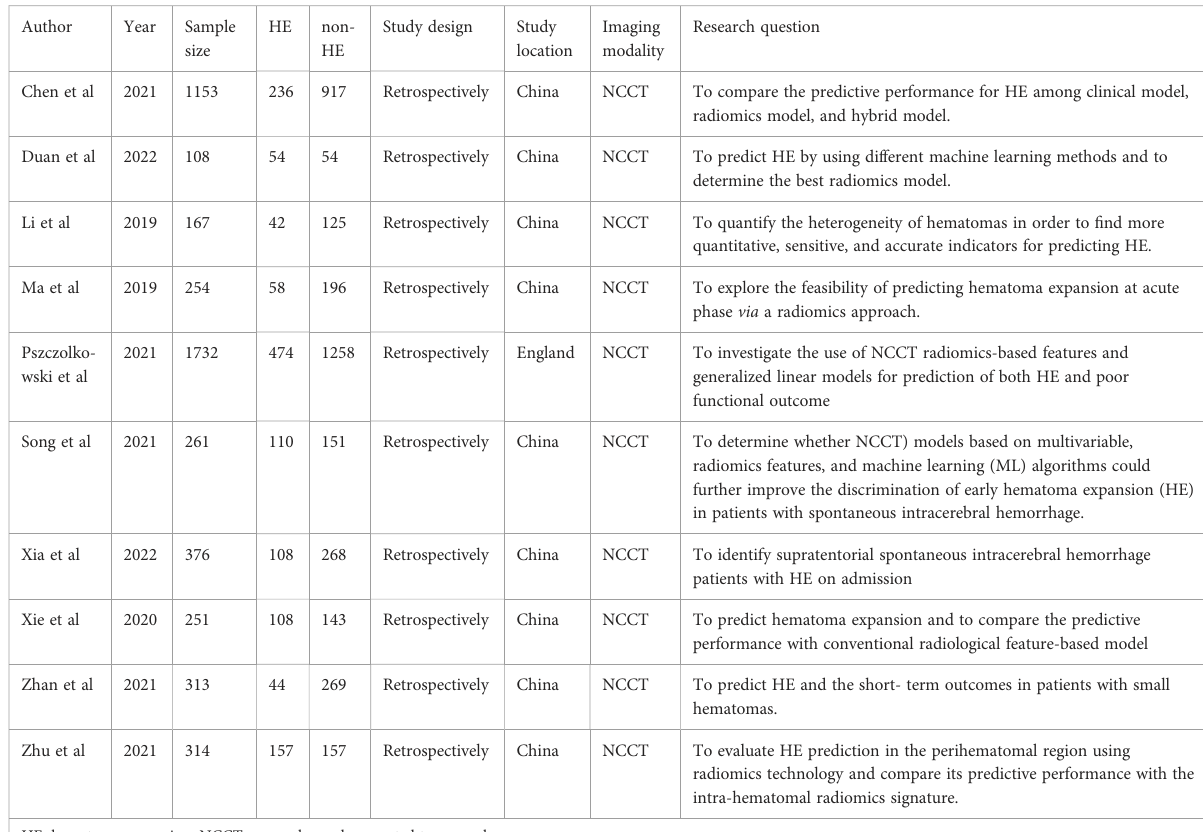
TABLE 1 Baseline characteristics of included